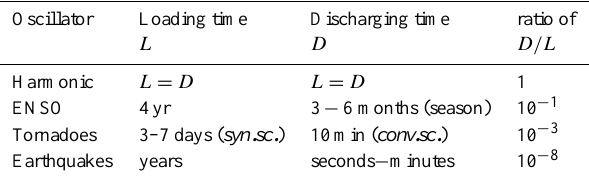
Table 4. Separation of time scales for different oscillators. Abbre- viations: syn.sc. : synoptic scale, conv.sc. : convective scale.